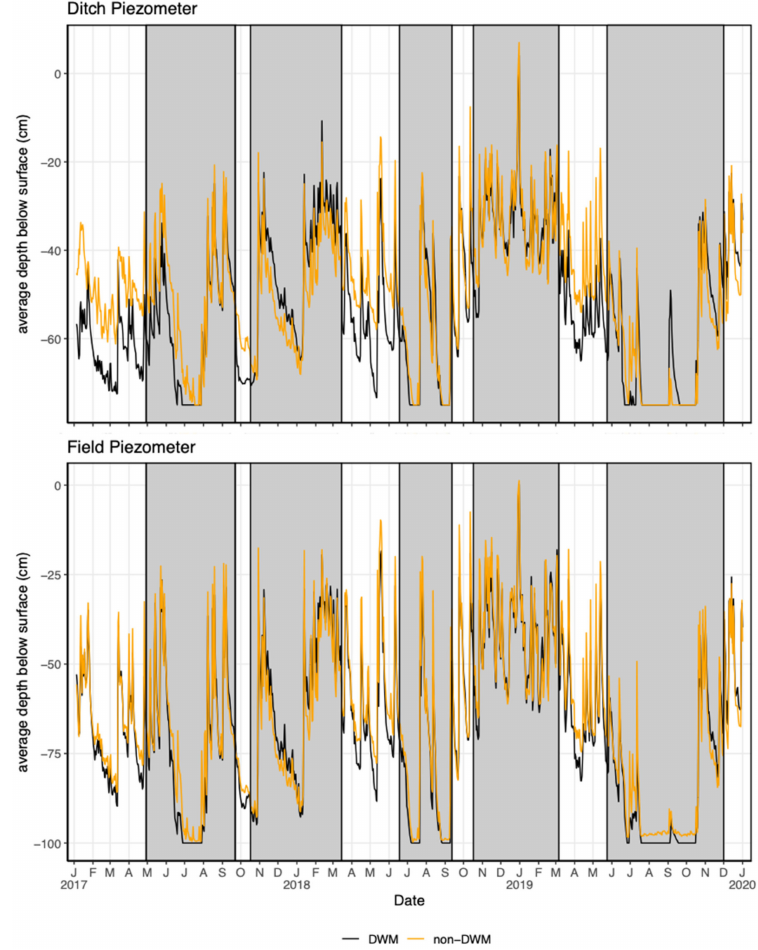
Figure 3. Mean piezometer water depth (cm) colored by treatment and piezometer location. The shaded time frame represents the active DWM DCS period and unshaded the inactive DWM DCS